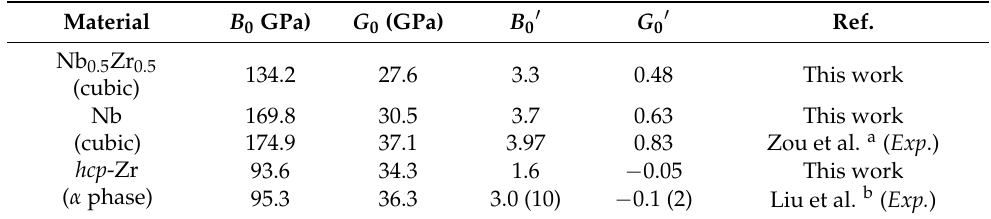
Table 2. Summary of elasticity of bulk and shear moduli, and their pressure derivatives for